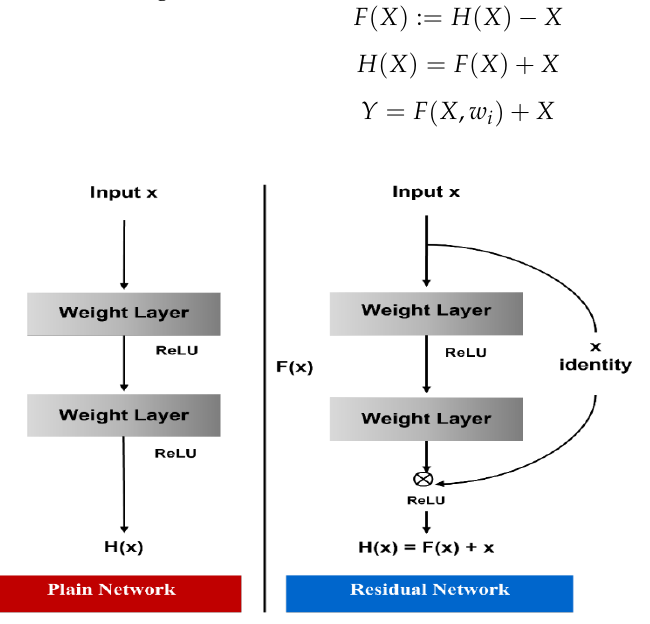
Figure 5. Residual learning.